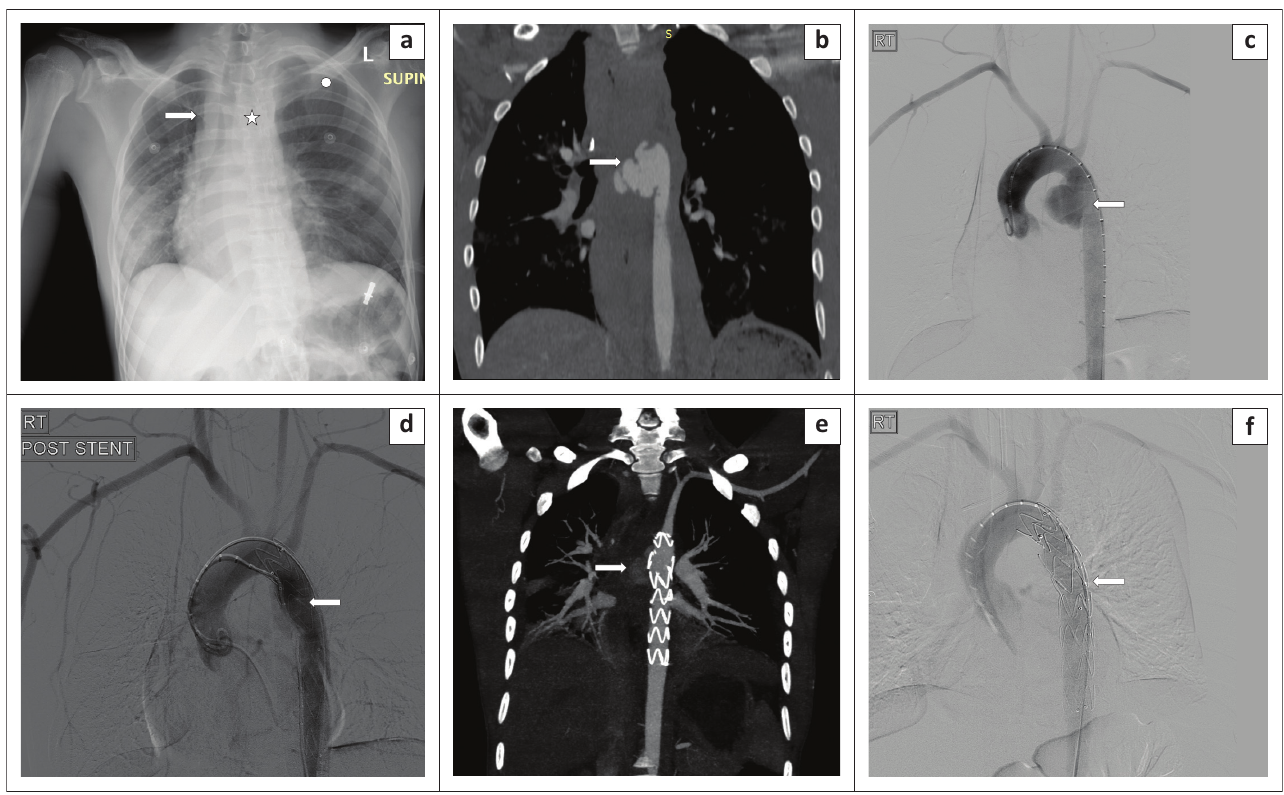
FIGURE 3: (a) Chest radiography in a 22-year-old male involved in a motor vehicle accident as a front passenger with a widened right paraspinal line (arrow), widened mediastinum (star) and depression of the left main bronchus, all signs pointing towards a vascular injury. Also note the tension pneumothorax on the left (circle) with contralateral mediastinal shift. (b) Computed tomography angiography in the same patient indicating the aortic injury and false aneurysm (arrow) at the isthmus. (c) Initial digital subtraction angiogram image pre-stenting revealing the pseudoaneurysm (arrow). (d) Digital subtraction angiogram image with the stent in place (arrow). (e) Follow-up computed tomography angiography demonstrating a leak around the stent (arrow). (f) A second endovascular stent was placed to treat the endoleak, sagittal oblique digital subtraction angiogram image with double stents (arrow).